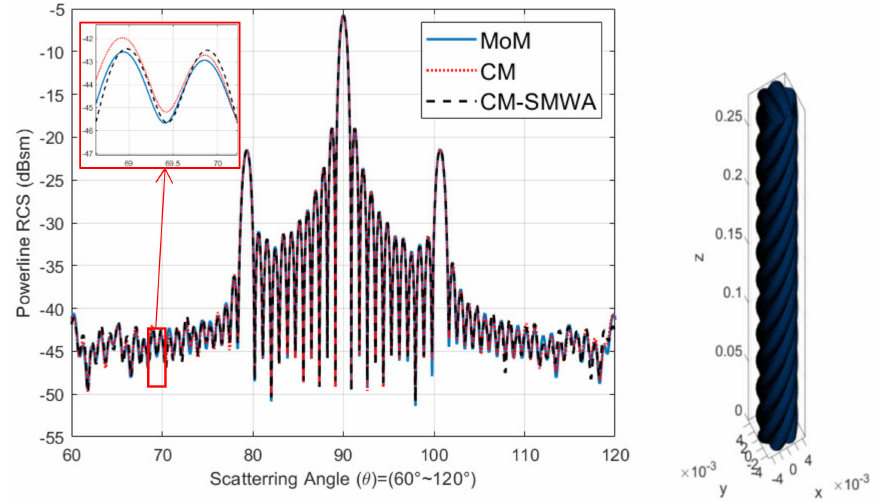
Figure 10. Simulation results of the power line RCS with the different algorithms at 35 GHz(H-H).